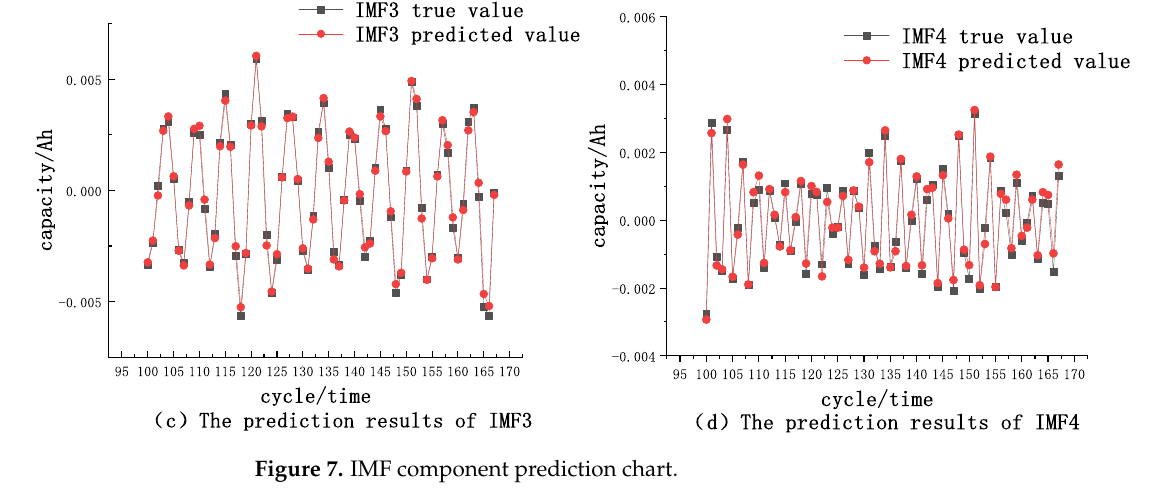
Figure 7. IMF component prediction chart.